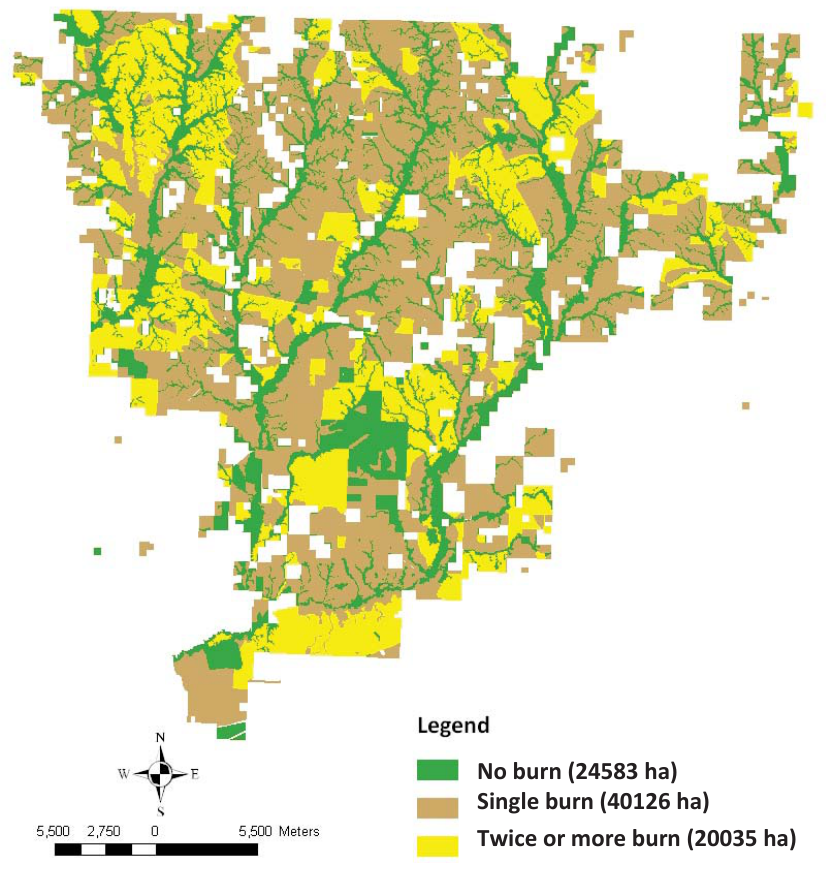
Figure 2. Location of burned and unburned areas within Blackwater River State